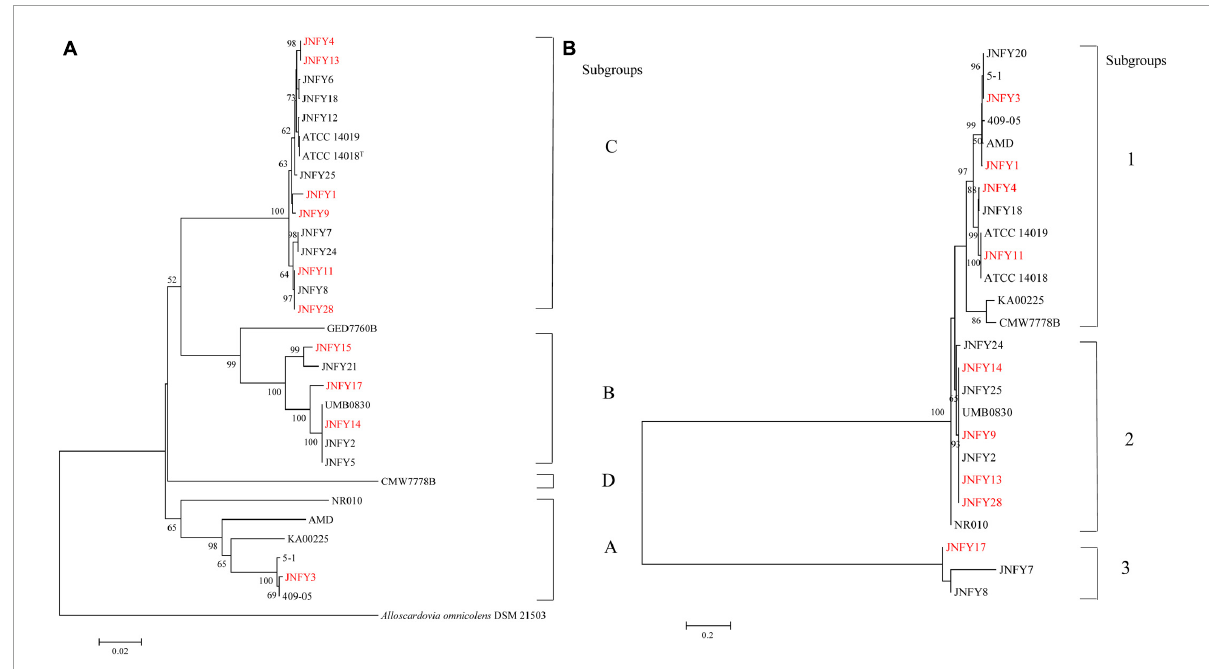
FIGURE1 Phylogenetic analysis of Gardnerella strains based on cpn60 (a) and vly (b) sequences. (A) Phylogenetic tree of Gardnerella cpn60 sequences comprising four distinct clades: (A–D). Bootstrap values for each node are indicated. ATCC 14018 T , ATCC 14019, 41V, 101, 1500E, AMD, 409-05, JCP8066, and JCP7719 are G. vaginalis isolates with whole genome sequence information available in Genbank (Accession numbers ADNB00000000, CP002104, AEJE00000000, AEJD00000000, GCA_000263595, ADAM00000000, CP001849, GCA_000414565, and GCA_000414625, respectively). (B) Phylogenetic tree of Gardnerella vly sequences comprising four distinct clades: 1, 2, 3, and 4 (no vly